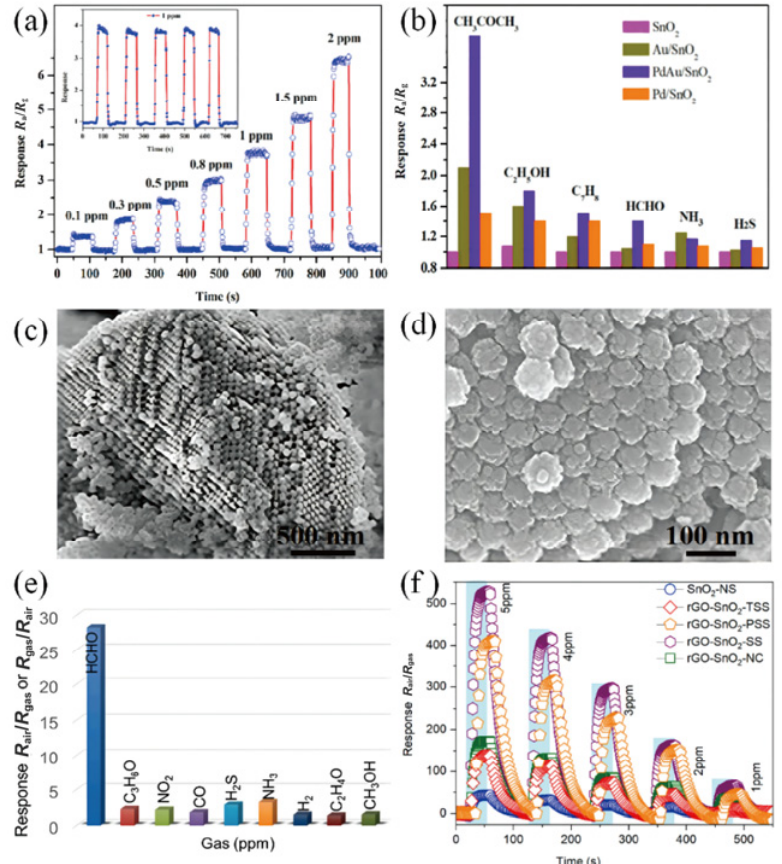
Fig. 8 (a) Representative dynamic response of Pd/Au–SnO 2 sensor to low acetone concentrations (0.1–2 ppm) at 250 ℃ .